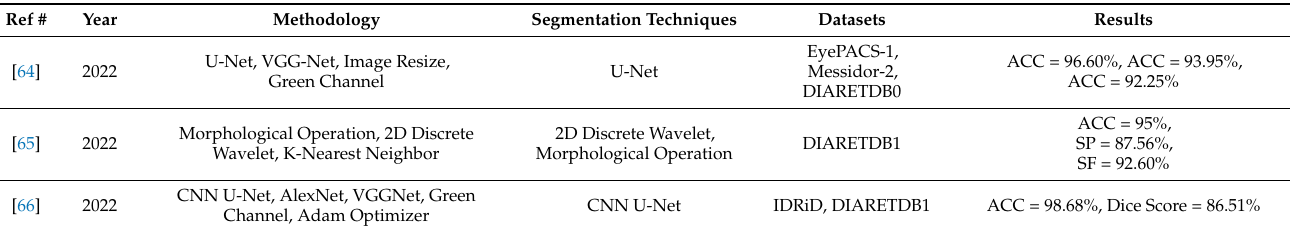
Table 4. Overview of reported techniques for DR lesion